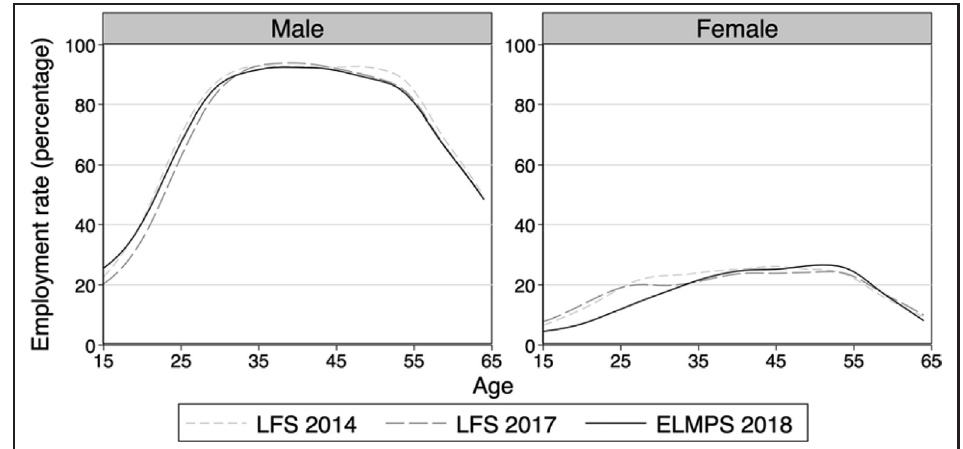
Employment rates (percentage) by sex, age, and data source.